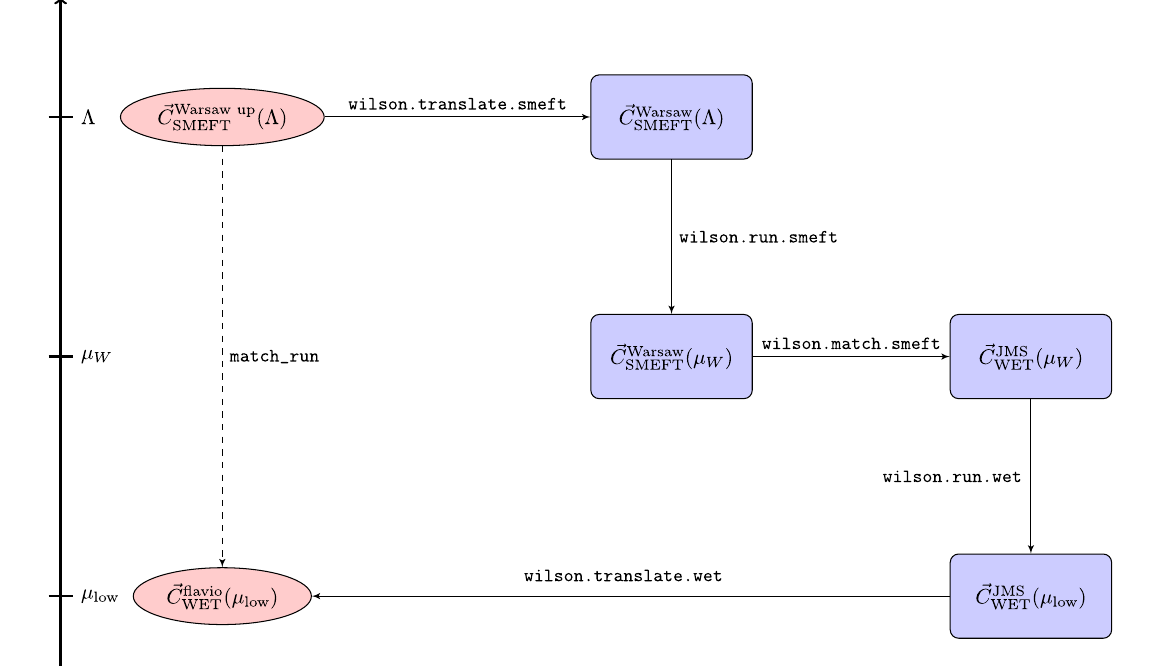
Fig. 1 Typical internal workflow in the wilson package: Starting from the SMEFT Wilson coefficients at the scale Λ , various submodules take care of the necessary basis translations, RG running, and matching to steps automatically